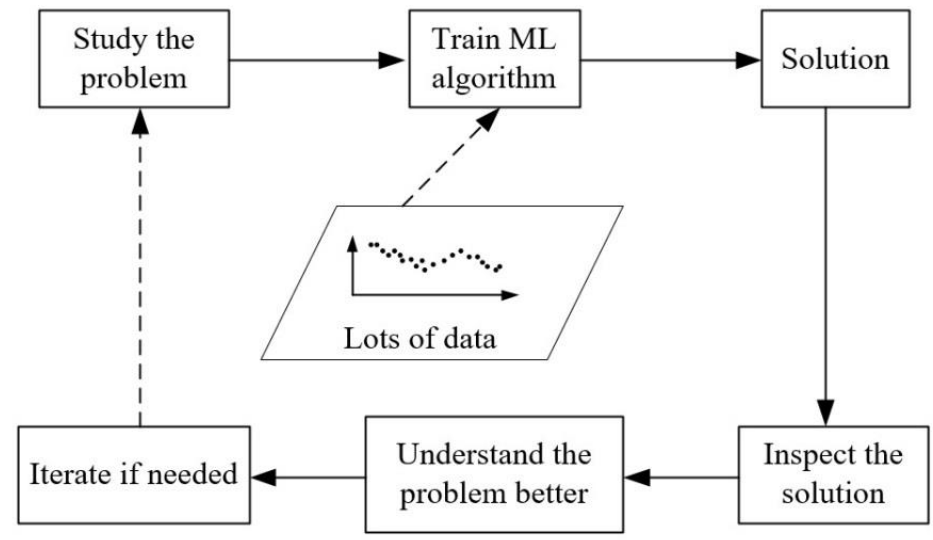
Figure 5. The principle of machine learning.